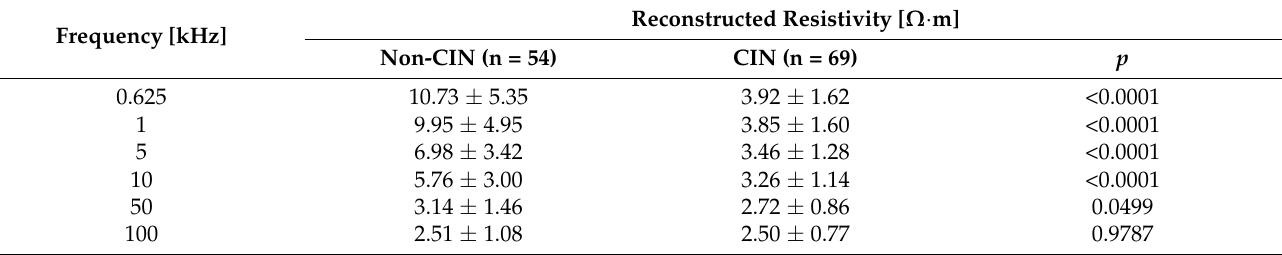
Abbreviation: CIN, cervical intraepithelial